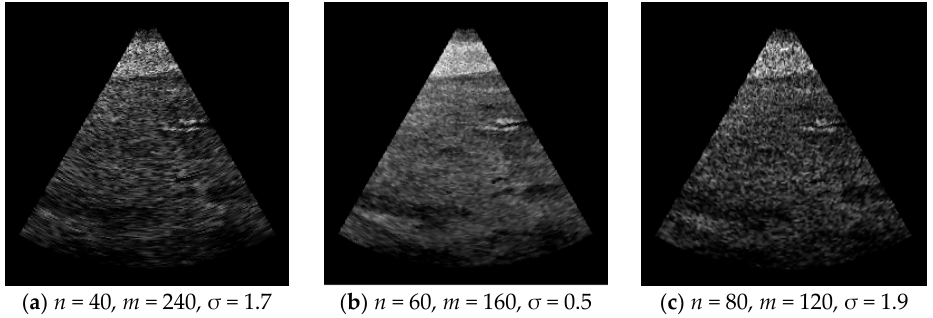
Figure 7. Image artifacts produced by large values of sampling and noise parameters ([13], reproduced with permission).